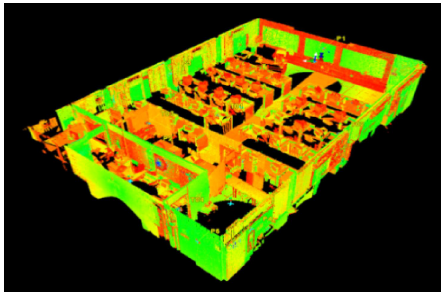
Figure 7. Result of point cloud registration